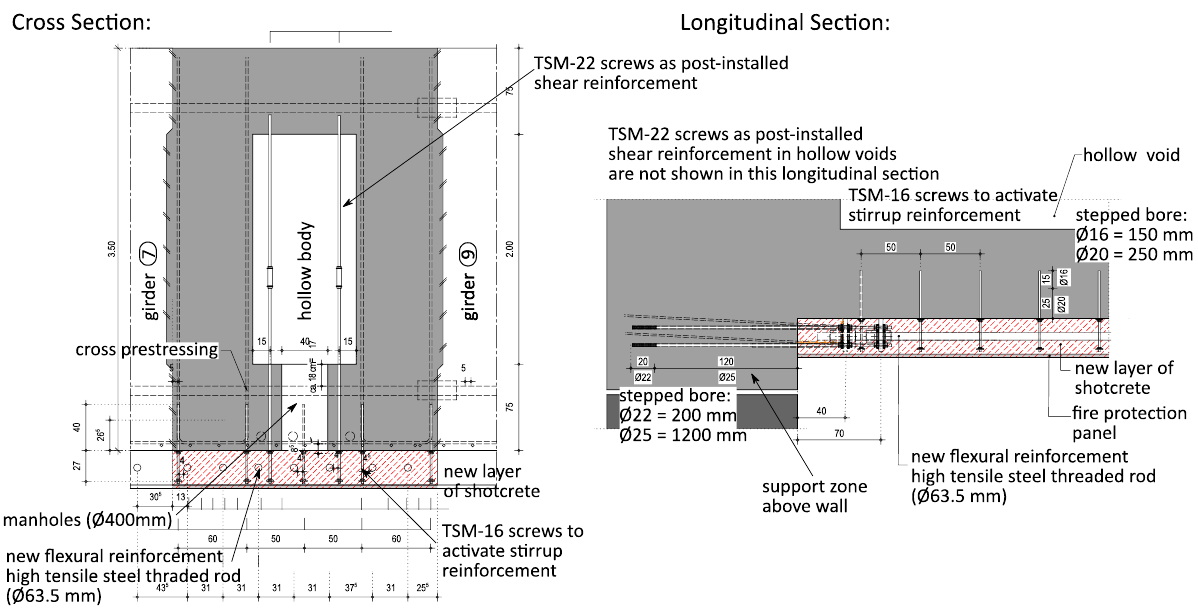
Figure 6. Planned shear and flexural reinforcement by the use of concrete screw anchors as shear reinforcement and threaded rods of high tensile steel as new flexural